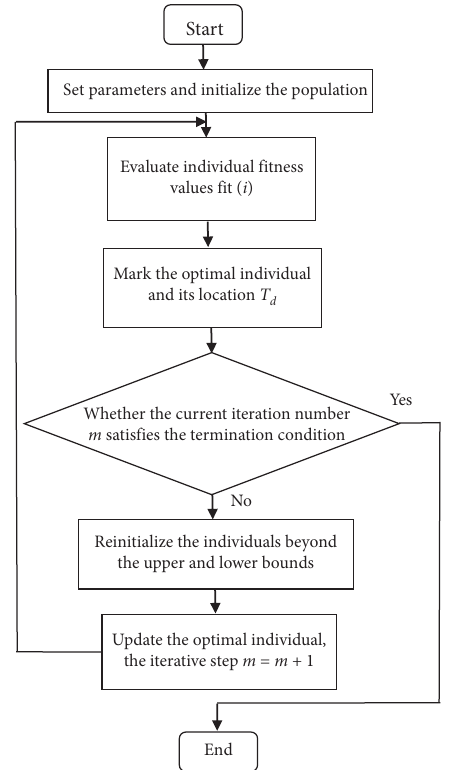
Figure 2: The flow chart of improved DBN based on